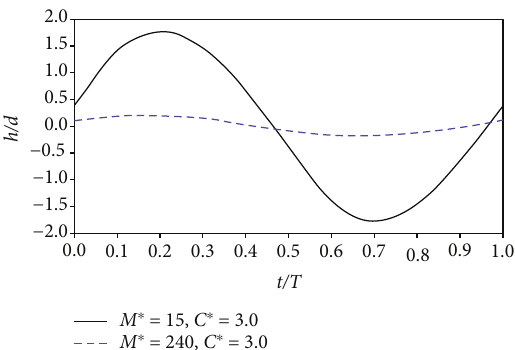
/ d of the considered cases with max M ∗ = 15 , C ∗ = 3 0 and M ∗ = 240 , C ∗ = 3 0 .